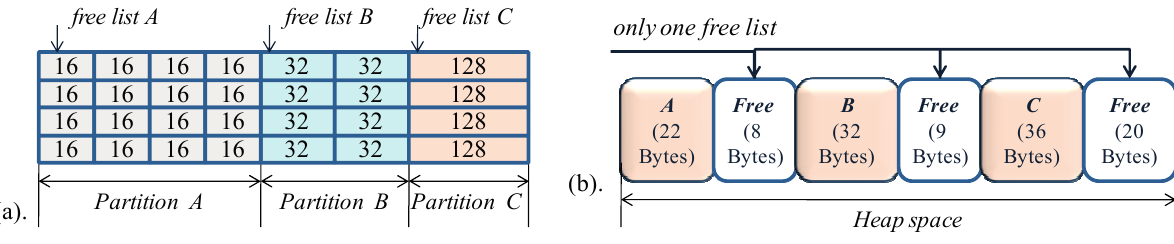
Figure 6. ( a ) SOS segregated free list (SFL) allocation. Three partitions ( A , B , C ) are pre-reserved. The block allocation is applied in each partition, and the block sizes in the different partitions are different. ( b ) mantisOS sequential fit (SF) allocation. Only one double-link free list is used to manage all the free